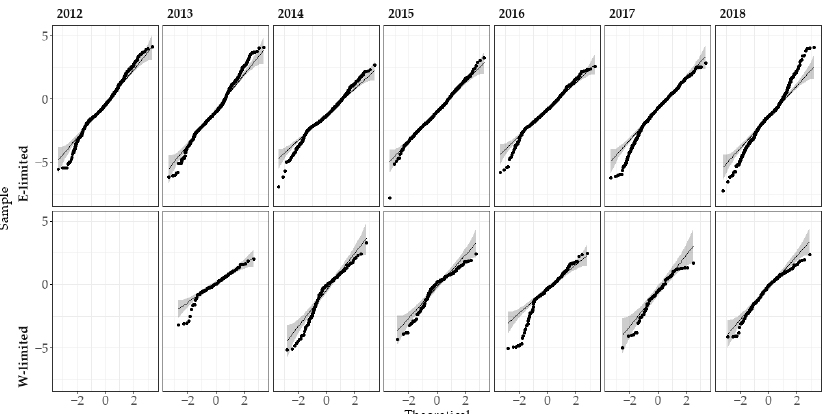
Figure A2. Mean annual grass height (H) for Rollesbroich, the energy-limited site (E-limited, blue) and Selhausen, water-limited site (W-limited, orange).